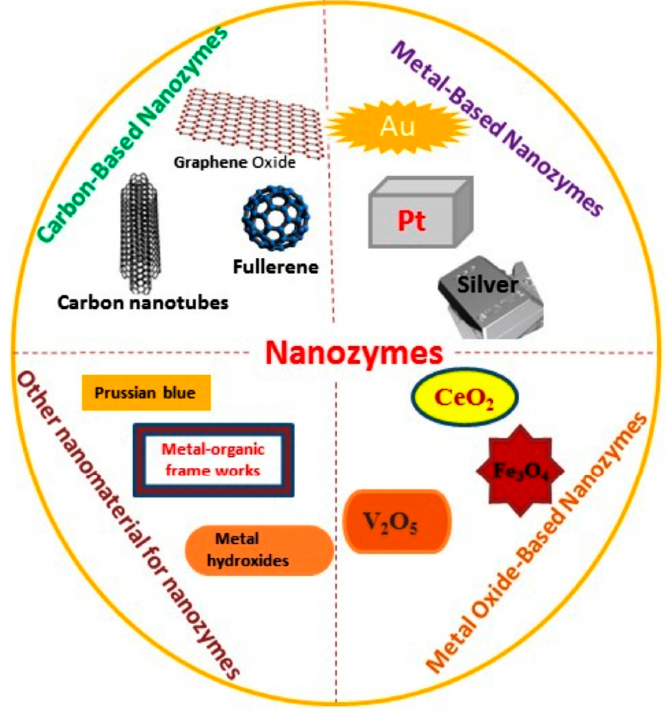
Figure 1. Classification of nanomaterial-based artificial enzymes (nanozymes).